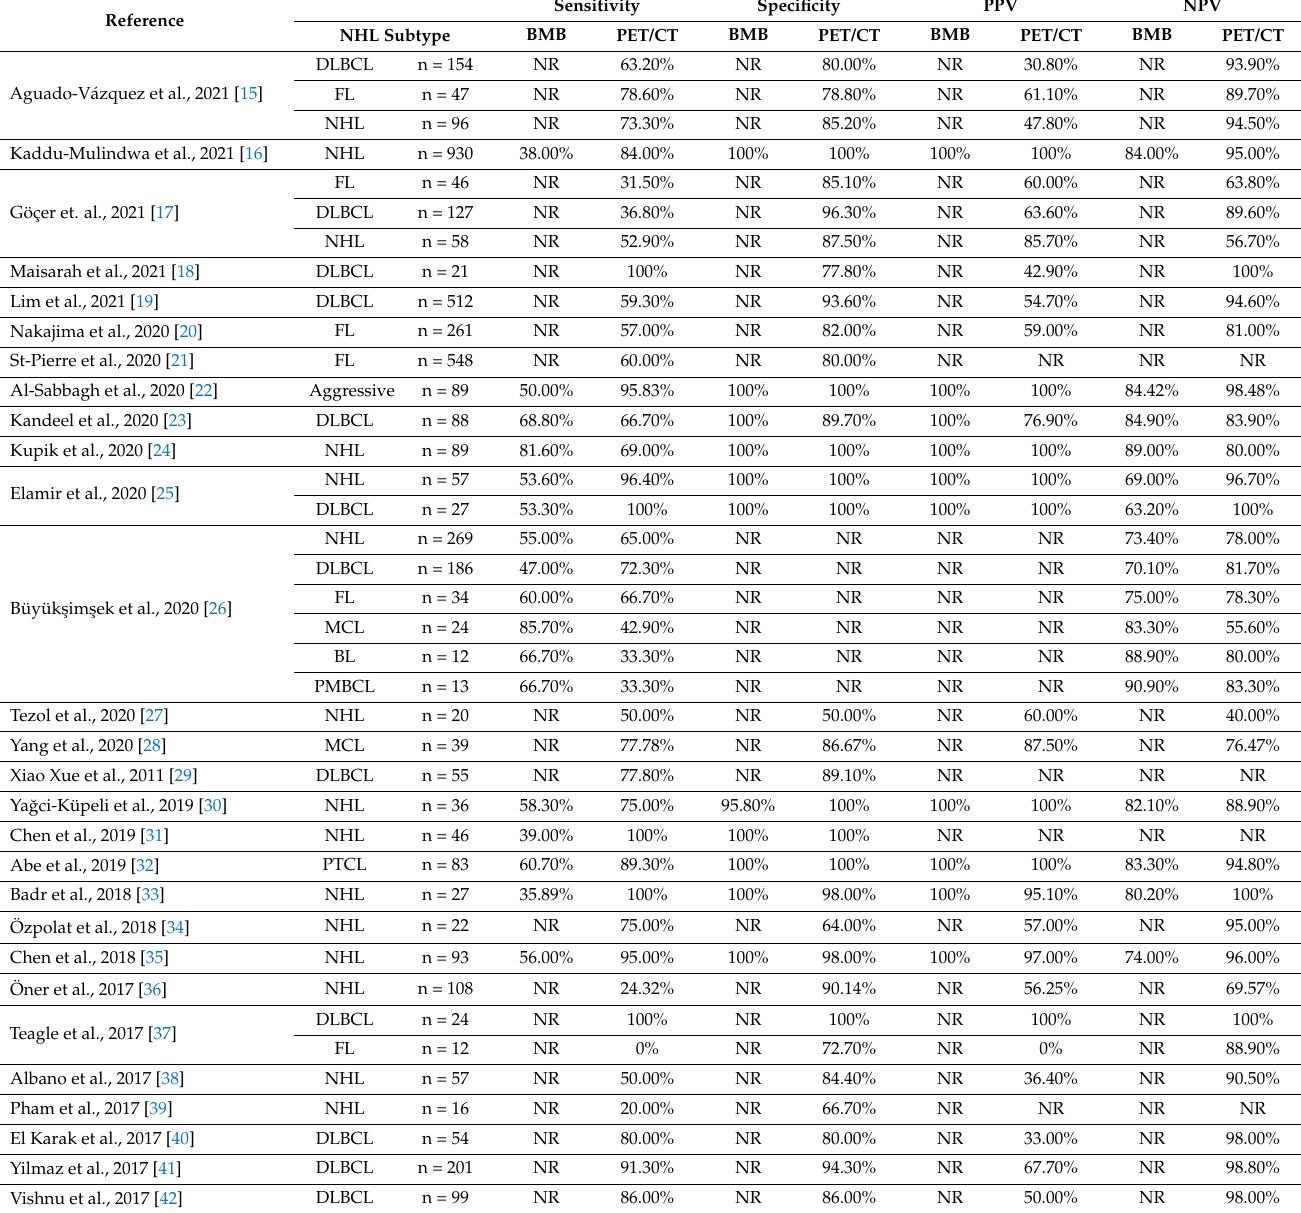
Table 3. Summary of the statistical measurements of the included studies. NR = Not